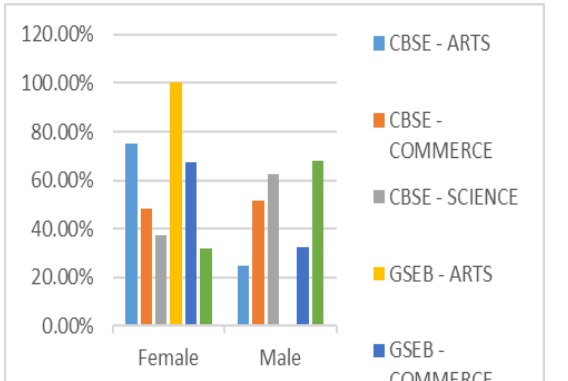
Figure 4. Distribution of data for college students’